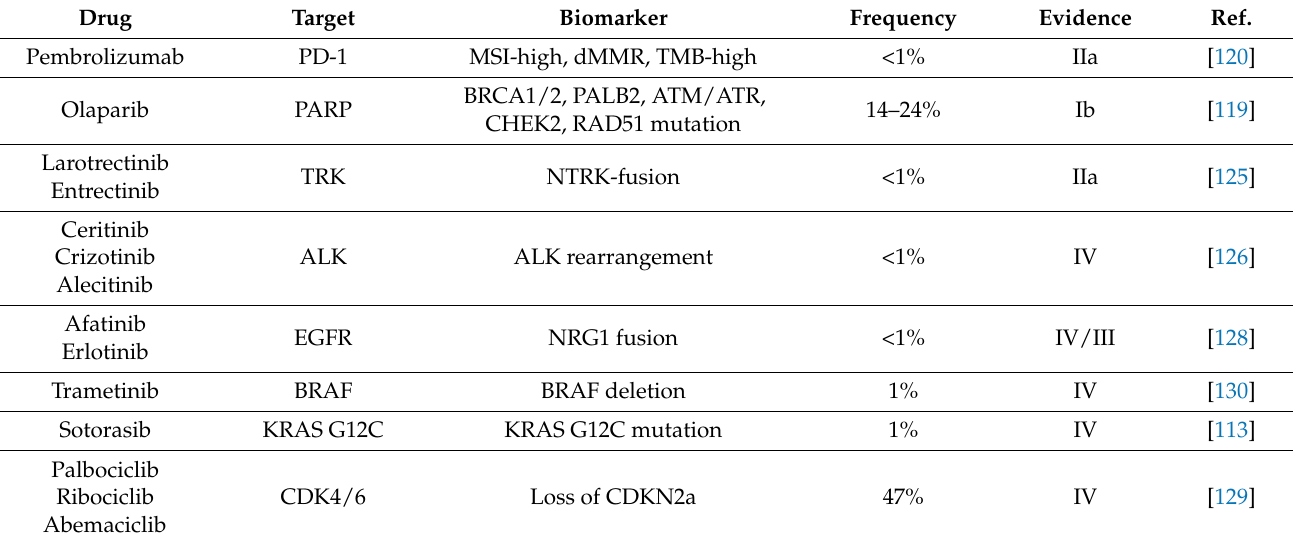
Table 2. Biomarkers as predictors for therapy response to targeted